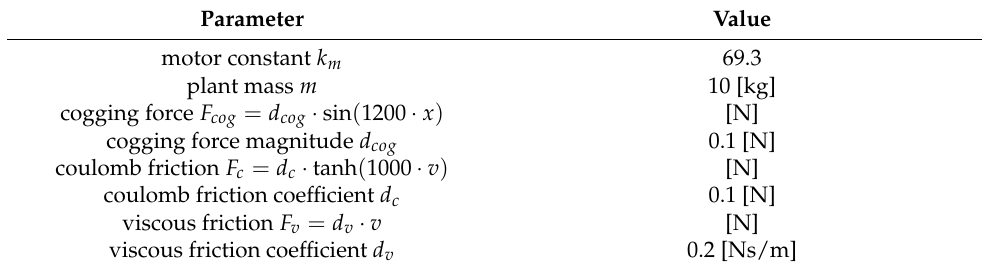
Figure 3. Nonlinear block diagram model of the simulated linear motor. Table 1. Parameters of the simulated linear